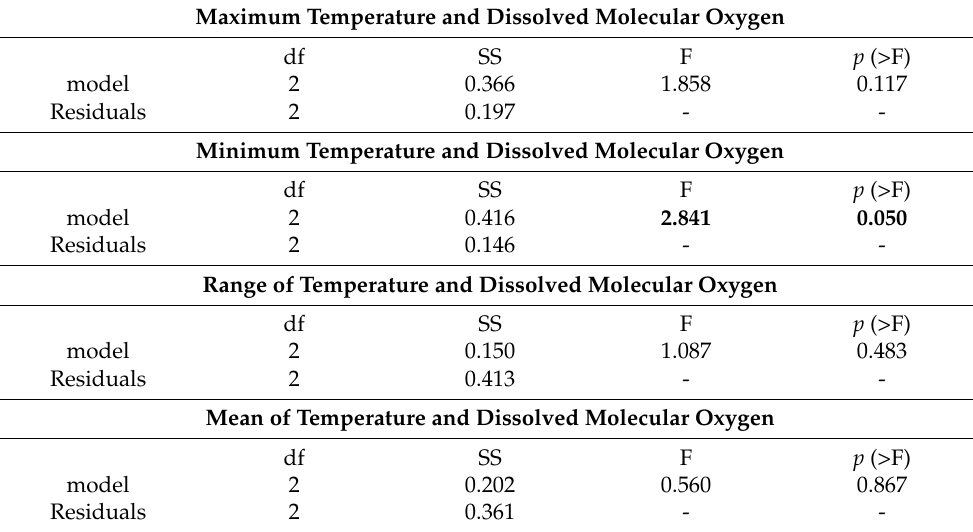
Table 3. ANOVA on the minimum SST and DO model to test the marginal effect of terms with 500 permutations to access.